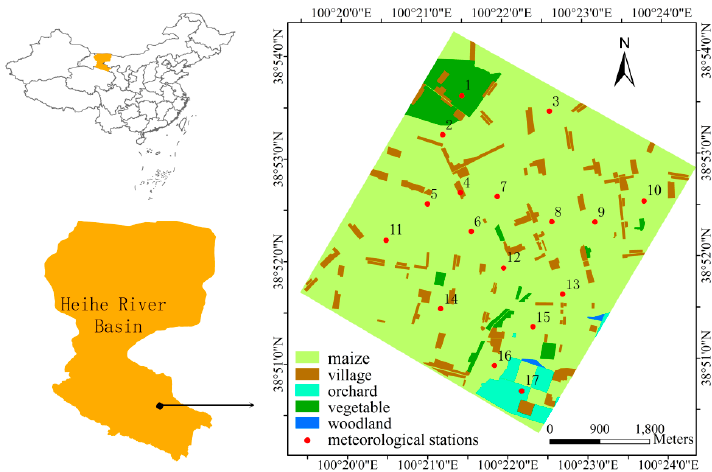
Figure 1. Location of the study area including land use status and 17 ground-based stations.